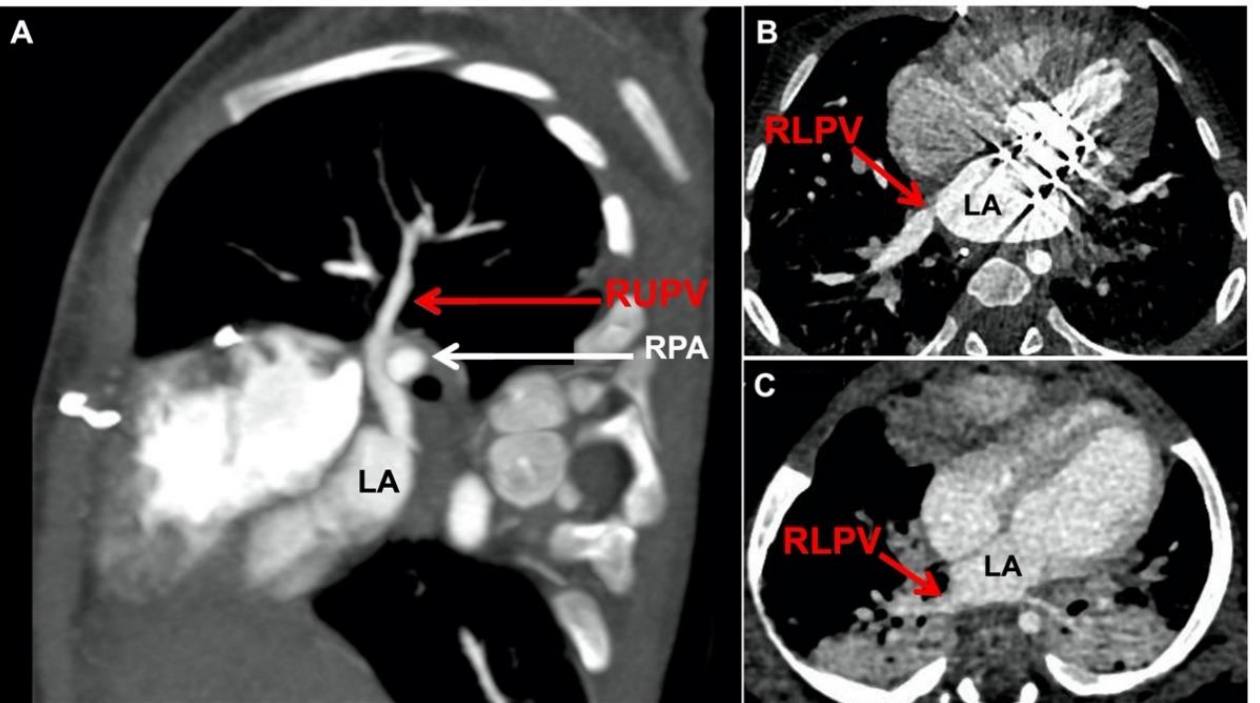
Figure 3. Right pulmonary veins (CT images). ( a ) Right upper pulmonary vein crosses over right pulmonary artery causing angulation as it passes across pericardial reflection into left atrium; ( b ) Right lower pulmonary vein stenosis involves more posteriorly directed pulmonary vein that angulates when crossing pericardial reflection; ( c ) Right lower pulmonary vein without stenosis has straight, less angulated course into left atrium. (RUPV = right upper pulmonary vein; RPA = right pulmonary artery; RLPV = right lower pulmonary vein; LA = left atrium).